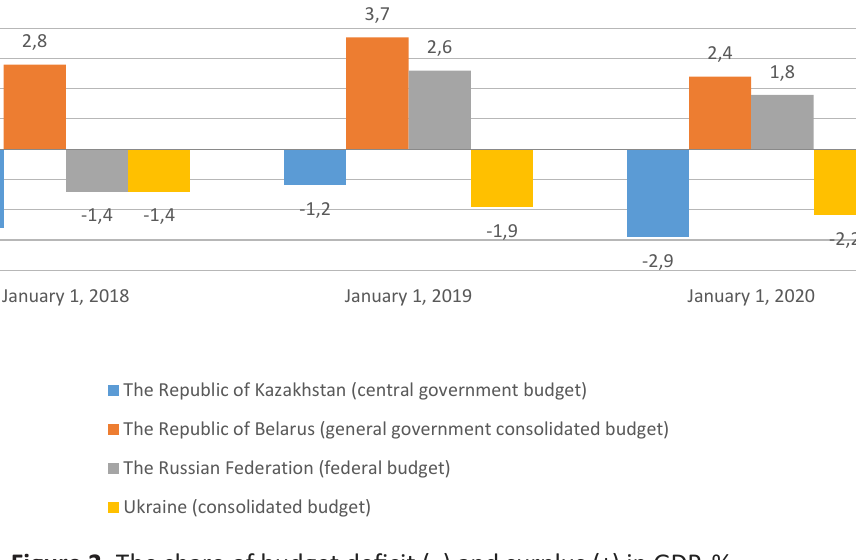
Figure 2. The share of budget deficit (–) and surplus (+) in GDP,